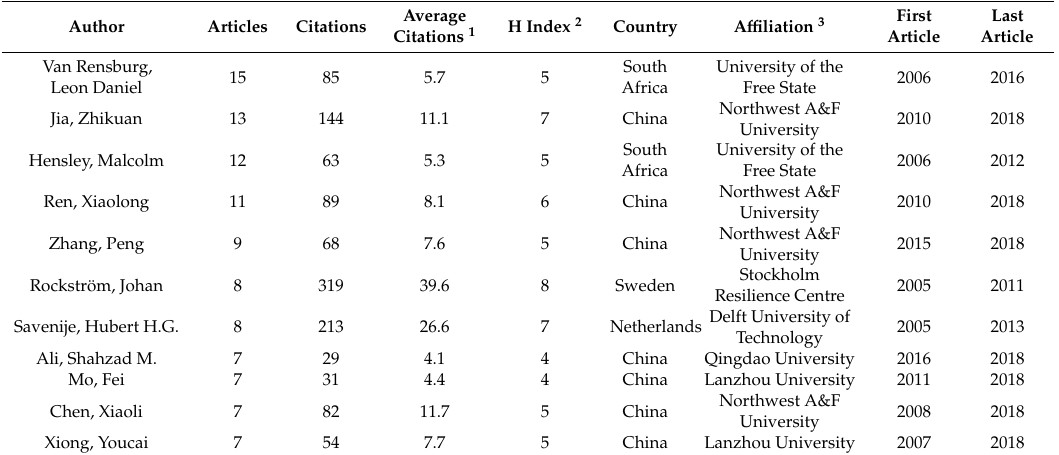
Table 7. Major characteristics of the most active authors in RWHI